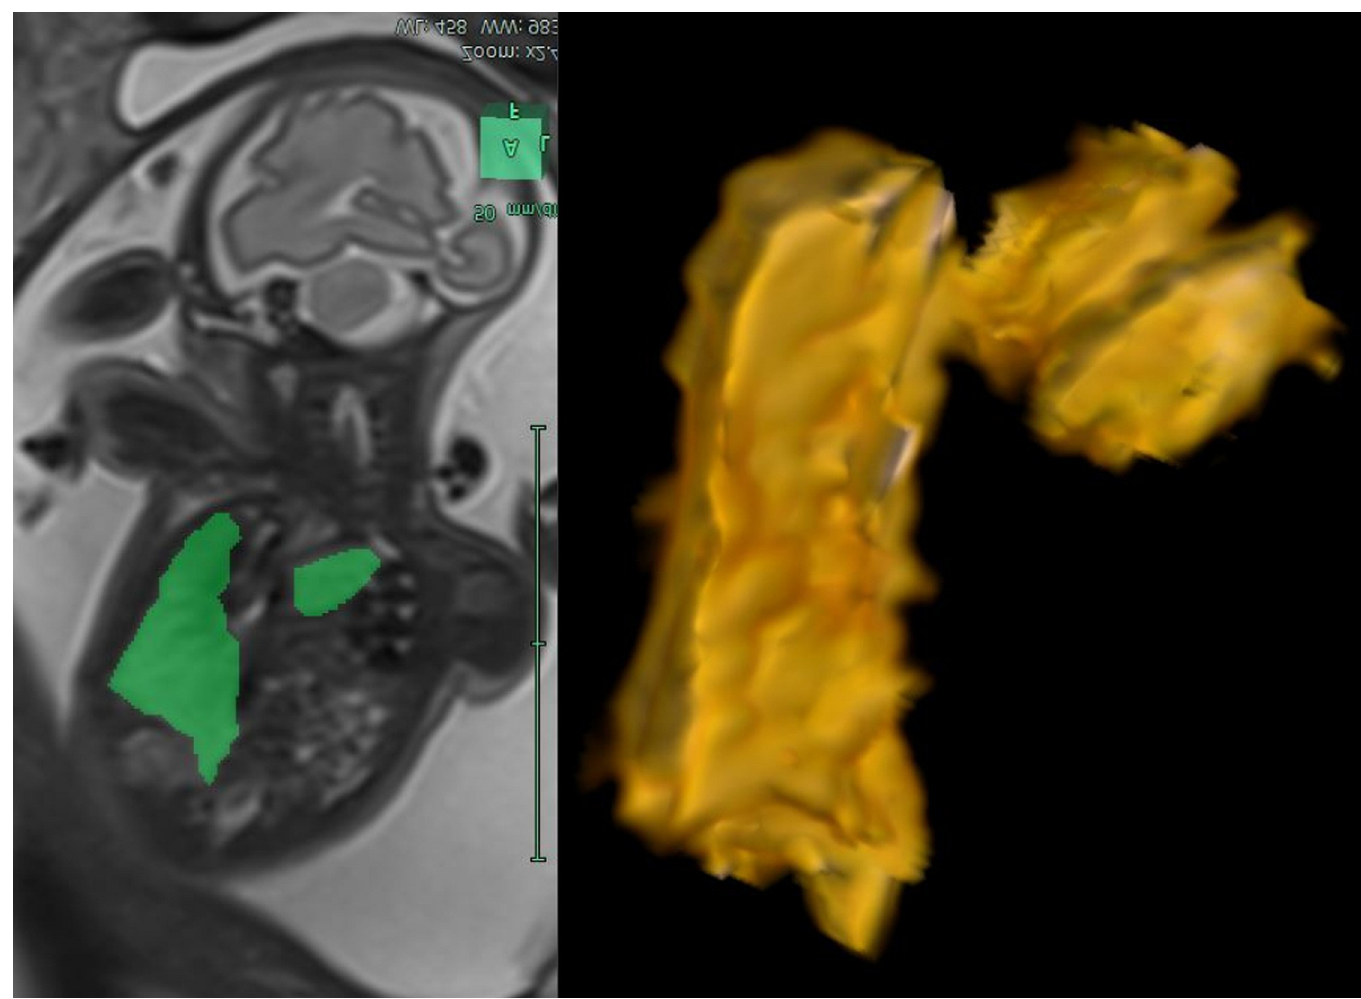
Fig 3. Total fetal lung volume assessment. MRI segmentation and 3D reconstruction of the fetal lung with the calculation of the total fetal lung volume on T2-sequences.